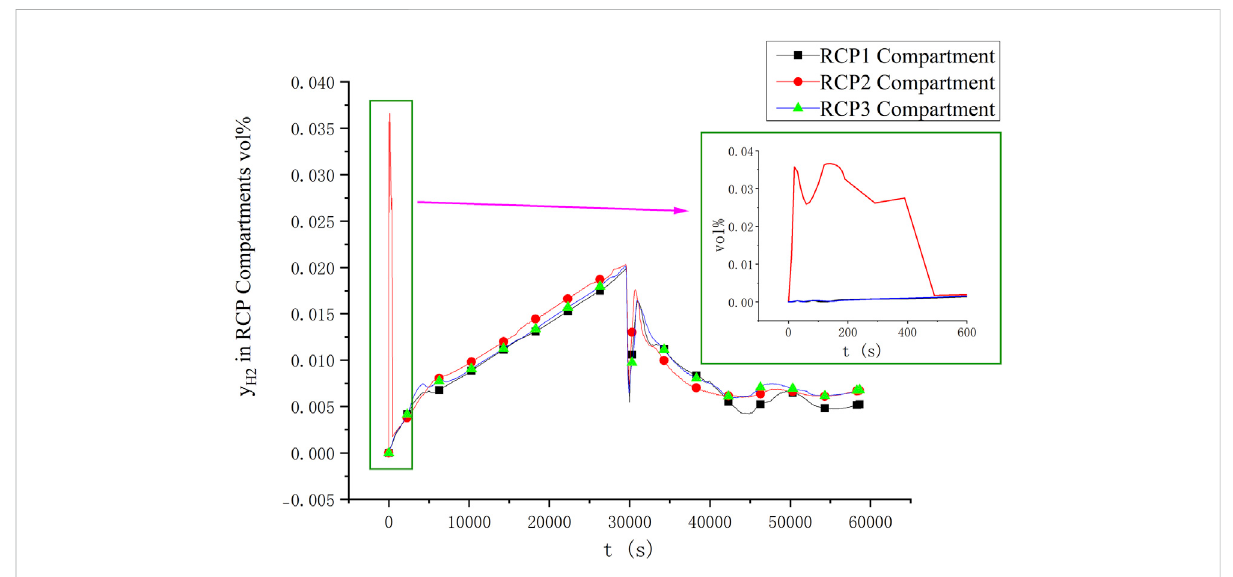
FIGURE 8 Variation of hydrogen concentration in RCP